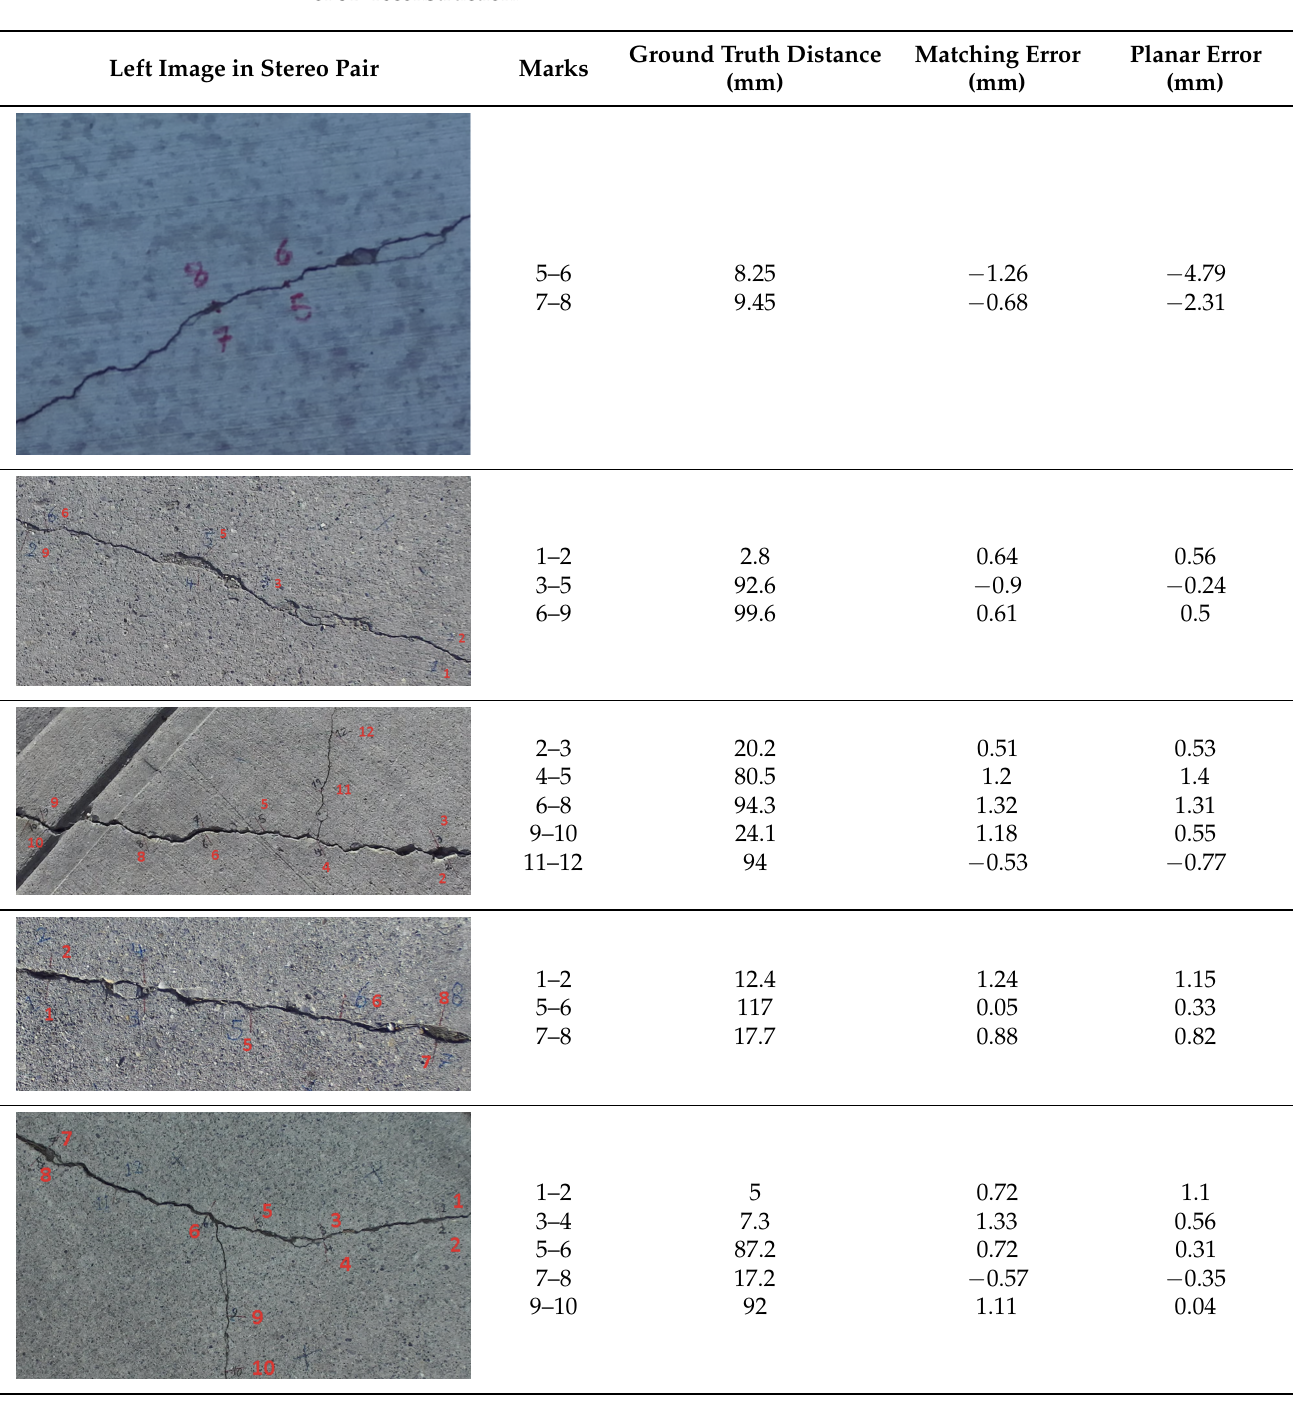
Ground Truth Distance Matching Error Planar (mm) (mm)